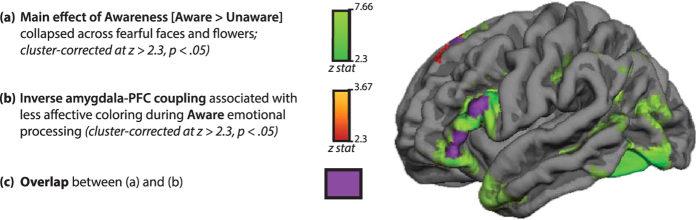
The main effect of awareness (aware – unaware) is shown in green, whole-brain cluster-level corrected for multiple comparisons at Z > 2.3, p < 0.05.The result of the regression of affective coloring behavior in the aware condition (i.e., neutral face likeability ratings following [fearful faces – flowers]) on amygdala functional connectivity (following [fearful faces – flowers]) is shown in red (i.e., same map as shown on Fig. 3A), and the overlap between these maps is shown in purple.